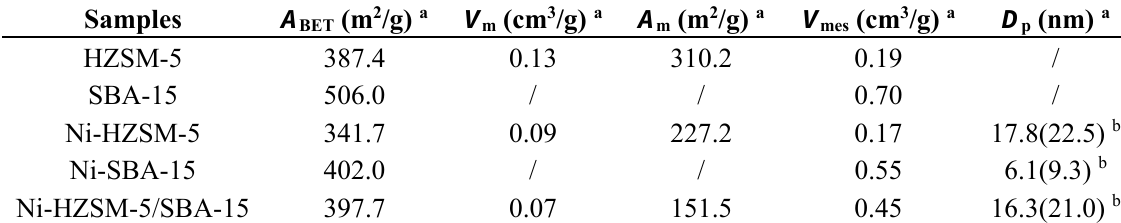
Table 1. Physicochemical property of catalysts.